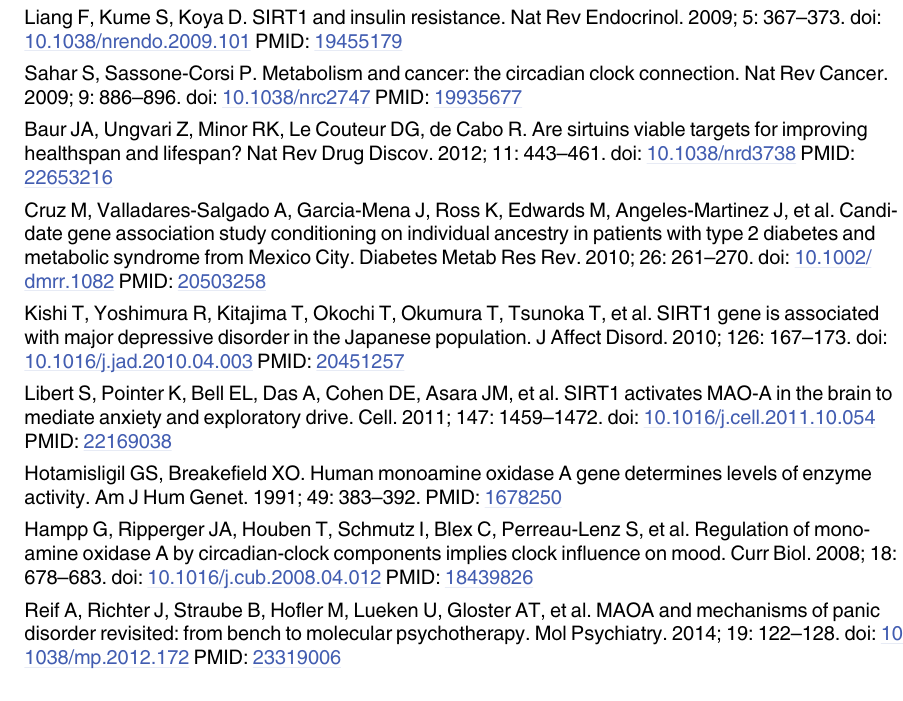
S1 Table. All results of the SIRT1 SNP